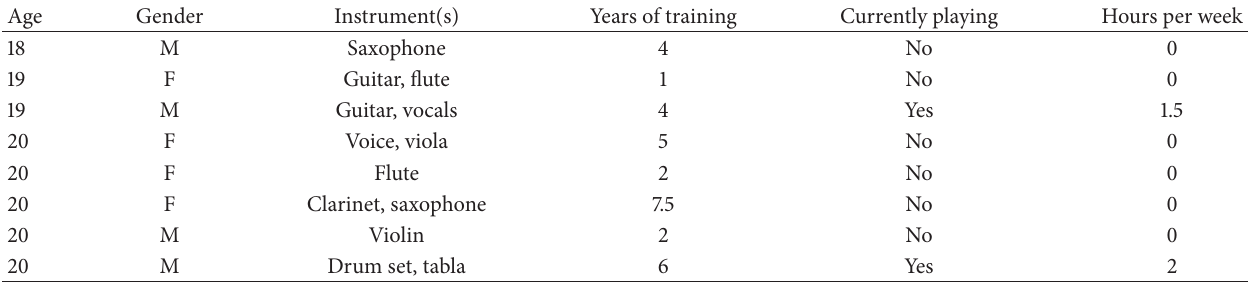
Table 1: Self-reported demographics for musical experience in subjects with past musical